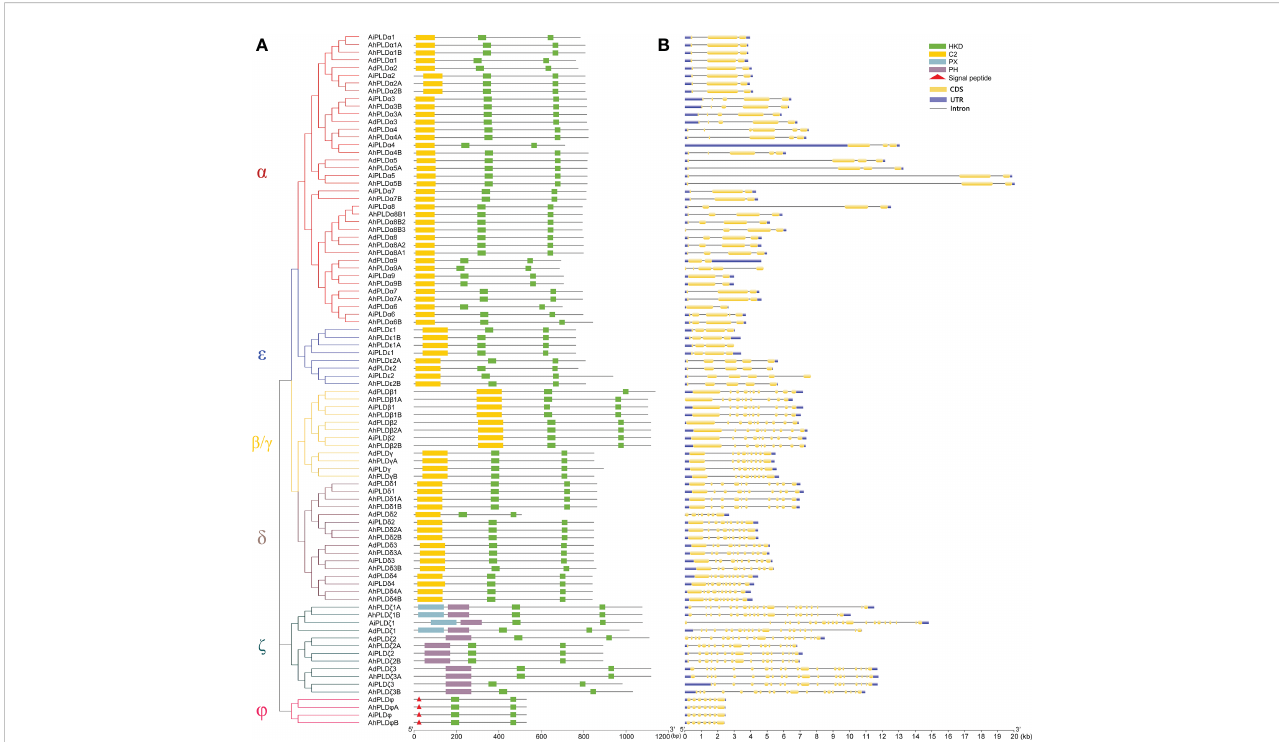
FIGURE 3 Phylogenetic relationship, conserved domains and gene structure of PLD genes in peanut and its two progenitors. (A) Schematic representation of the phylogenetic tree and conserved domain of PLD genes in three Arachis species. The red, blue, yellow, purple, dark green and pink branches on phylogenetic tree represent the a , e , b / g , d , z and f isoforms, respectively. The yellow, green, blue and purple rectangles represent the C2, HKD, PX and PH domains, respectively. The red triangles represent the signal peptides. (B) Exon-intron structure of PLD genes in three Arachis species. The blue boxes represent exons. The yellow boxes represent coding sequences. The black lines represent